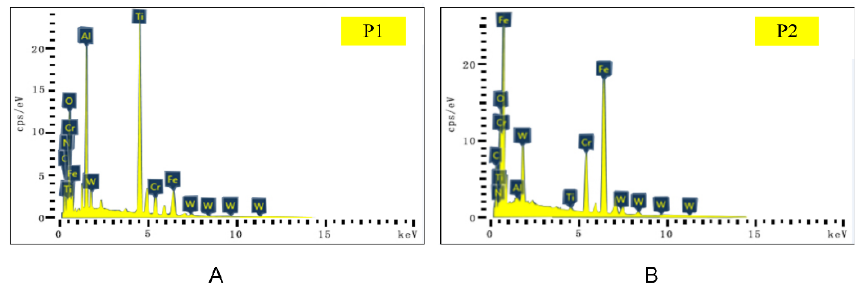
Figure 14. EDS analysis results of corresponding points P1 ( A ) and P2 ( B ) in Figure 13.